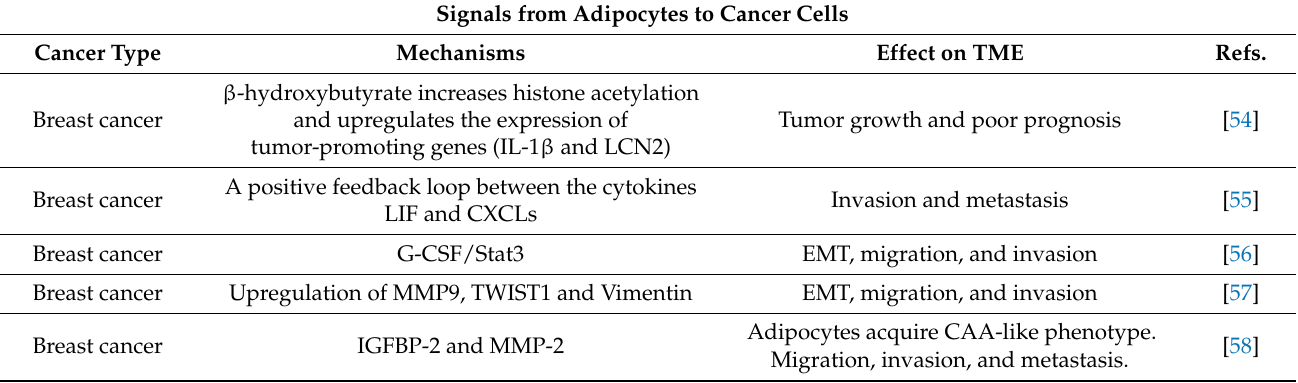
Table 2. Paracrine communication between adipocytes, macrophages, and cancer cells in the tumor